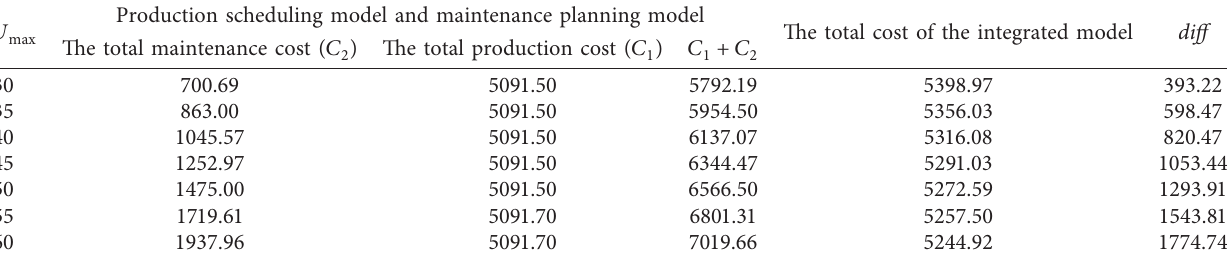
Table 6: The difference value between the independent model and integrated model ( N �